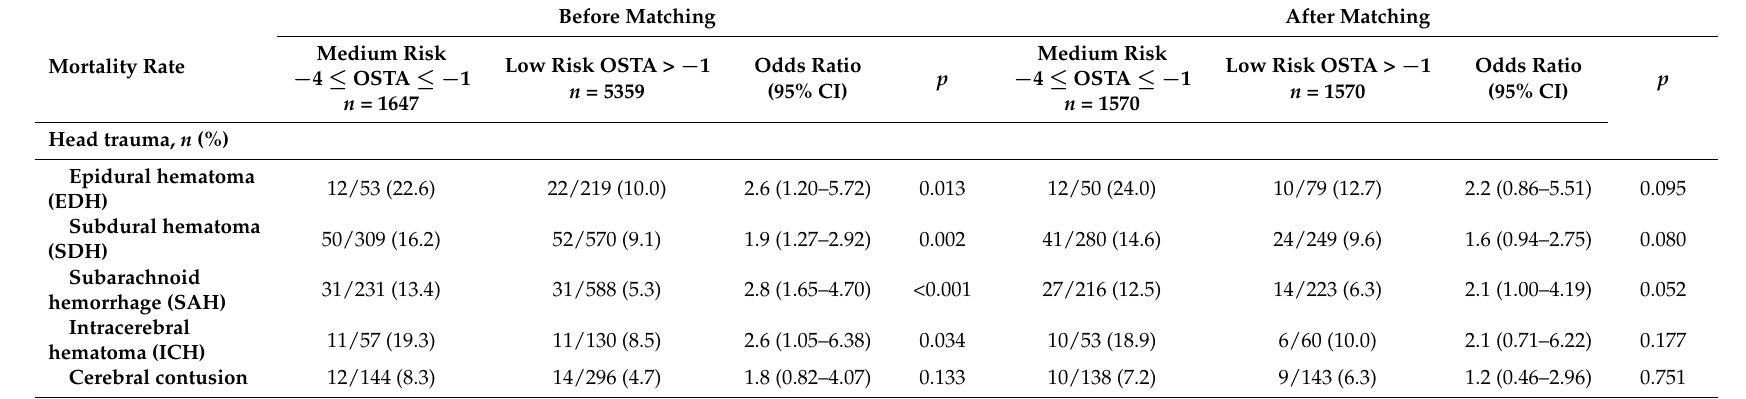
Table 6. Mortality rate of different types of trauma injury to the brain in medium-risk vs. low-risk patients.